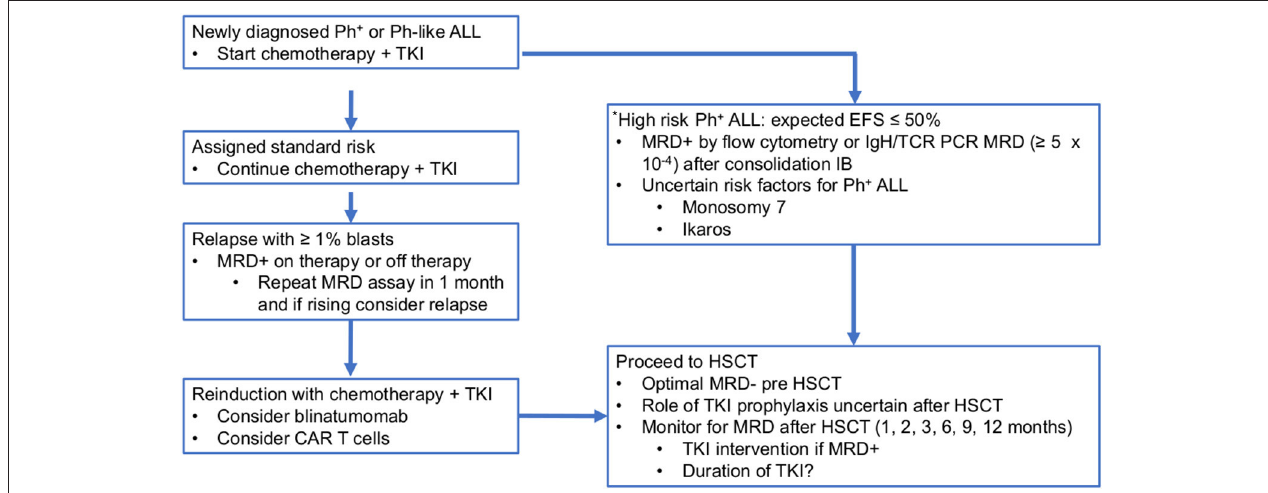
FIGURE 2 | Proposed treatment algorithm for HSCT in paediatric Ph + and Ph-like ALL. *There are no defined criteria for high-risk Ph-like ALL at present. ALL, acute lymphoblastic leukaemia; CAR, chimeric antigen receptor; HSCT, haematopoietic stem cell transplantation; IB, consolidation; MRD, minimal residual disease; Ph + , Philadelphia chromosome; TKI, tyrosine kinase